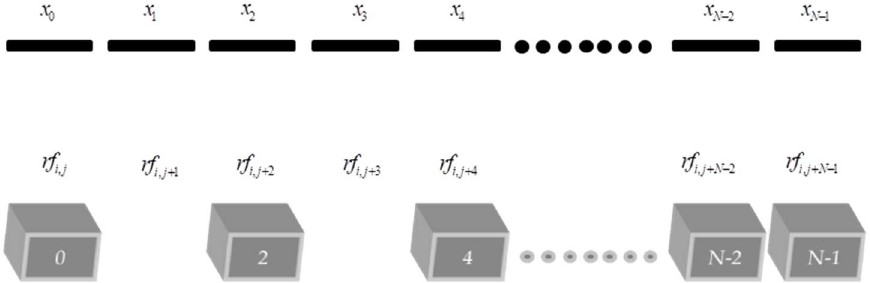
Figure 7. Representation of each transducer element ( x 0 − x N − 1 ) and the sparse rf data to be interpolated (odd positions). The last right element is always valid.